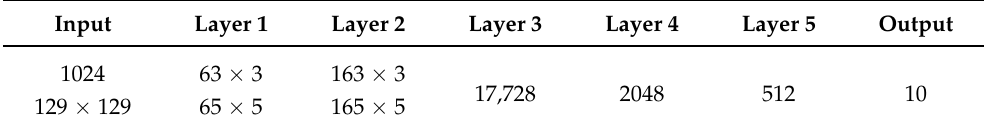
Table 1. The proposed model